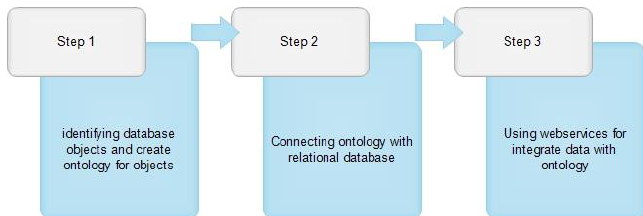
Figure 2. Steps for implementing